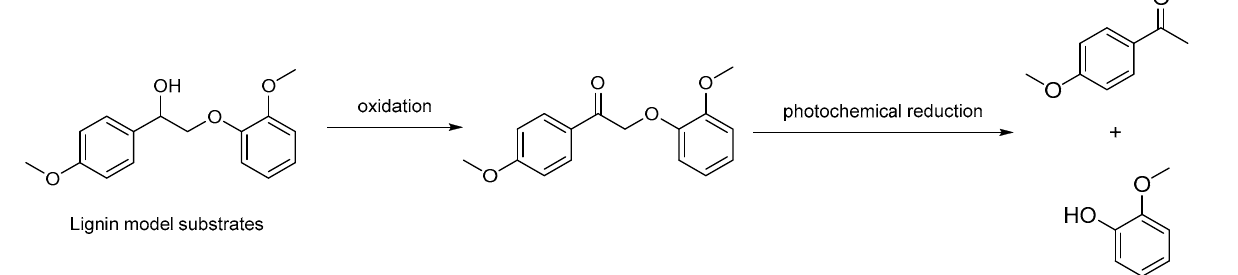
Scheme 13. Cycloadditions of 4-vinylbenzoic acid derivatives by the photocatalysis with CdSe QDs. In 2019, Weiss et al. [42] presented a series of aqueous acrylamides and acrylates that polymerized though photoinduced electron transfer reversible addition-fragmentation chain transfer (PET-RAFT) with high efficiency, low dispersity, and ultralow catalyst loading (Scheme 14). The water-soluble MPA-capped CdSe QDs (diameter = 2.8 nm) photocatalyst could be separated from the system by using protein concentrators and reused four times with high activity, and the monomer in the reaction mixture could be isolated selectively by different pore sizes of protein concentrators in the same way. Following that, Egap et al. [43] also designed a PET-RAFT polymerization to syn- thesize core-shell polymer-QDs (diameter = 3.8 nm) nanocomposites using CdSe quan- tum dots in a polar solvent. Herein, CdSe QDs (diameter = 3.2 nm) were not only the photocatalyst, but also the inorganic building block for nanoparticle–polymer hybrid nanocomposites. CdSe QDs were stable in polar solvents such as Dimethyl Formamide (DMF) and dimethylsulfoxide (DMSO) due to the ligand exchange by chain transfer agents on the surface of CdSe